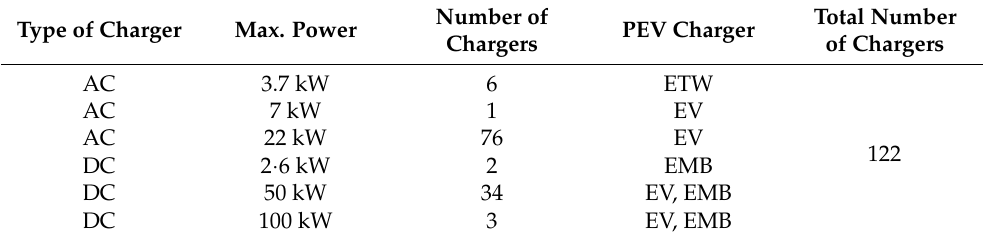
Table 2. Charger characteristics.